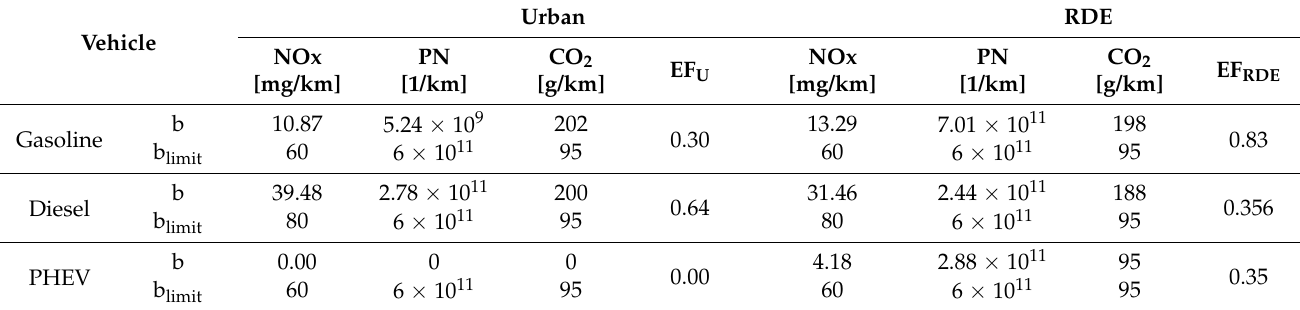
Table A3. Emission factors (EF) for passenger cars (health option, α NOx = 0.45, α PN = 0.45, α CO2 = 0.1). Vehicle